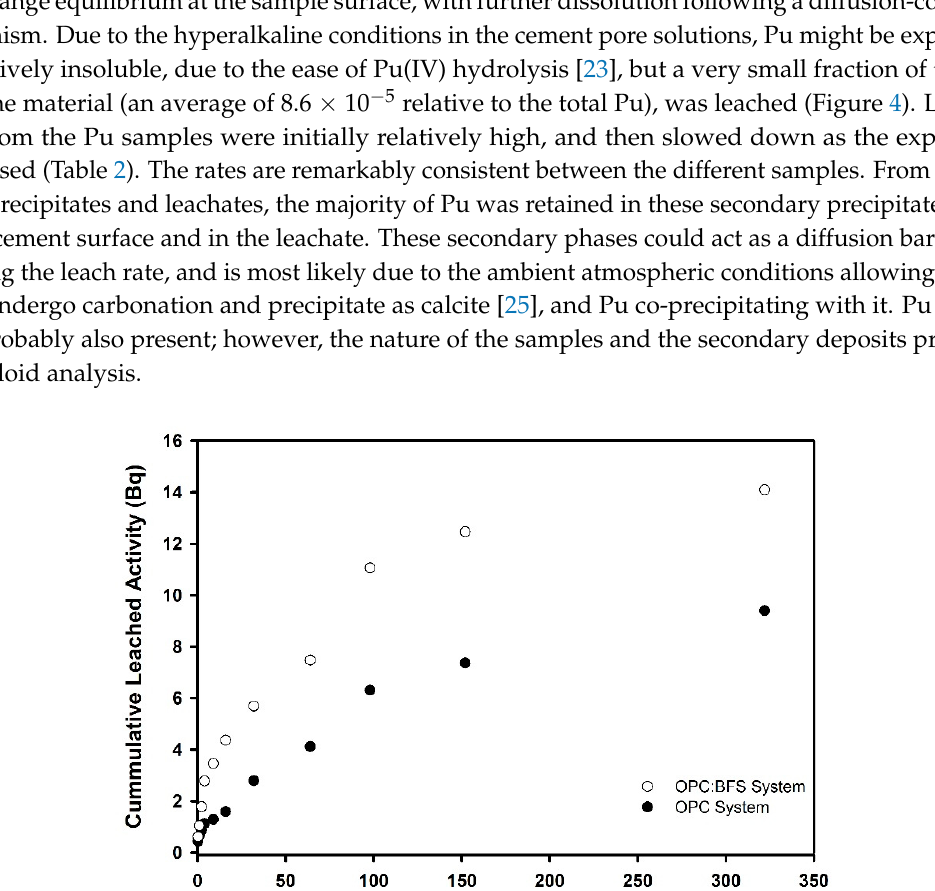
√ time in Supplementary